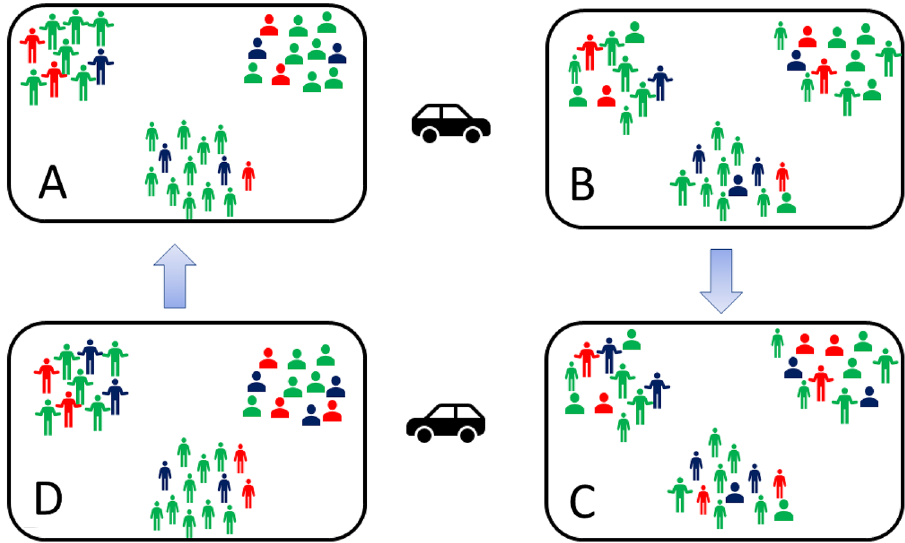
Figure 1. Conceptual view of the model. Different colors represent different epidemic conditions e.g. uninfected, sick etc., and different icons represent the residents of different locations. ( A ) The situation at the beginning of the day. ( B ) After transportation, the number of people in each location has changed, but total number in each compartment is conserved. ( C ) Due to the epidemic model individual may move to a different compartment. No change in total number at each location. ( D ) Reverse commuting. Number in each location is the same as in the morning. Total number in each compartment is the same as in ( C